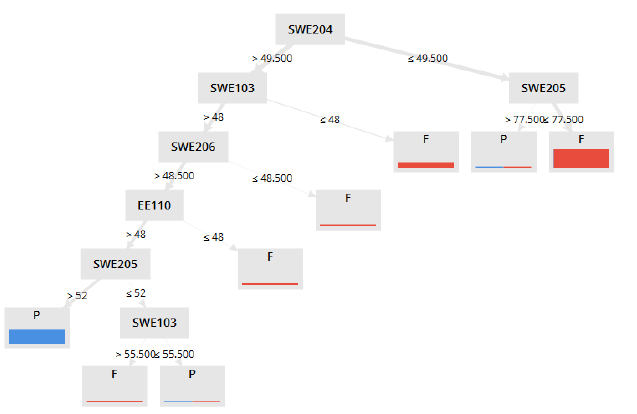
Fig. 5. Decision tree with gain ratio for dataset 1.